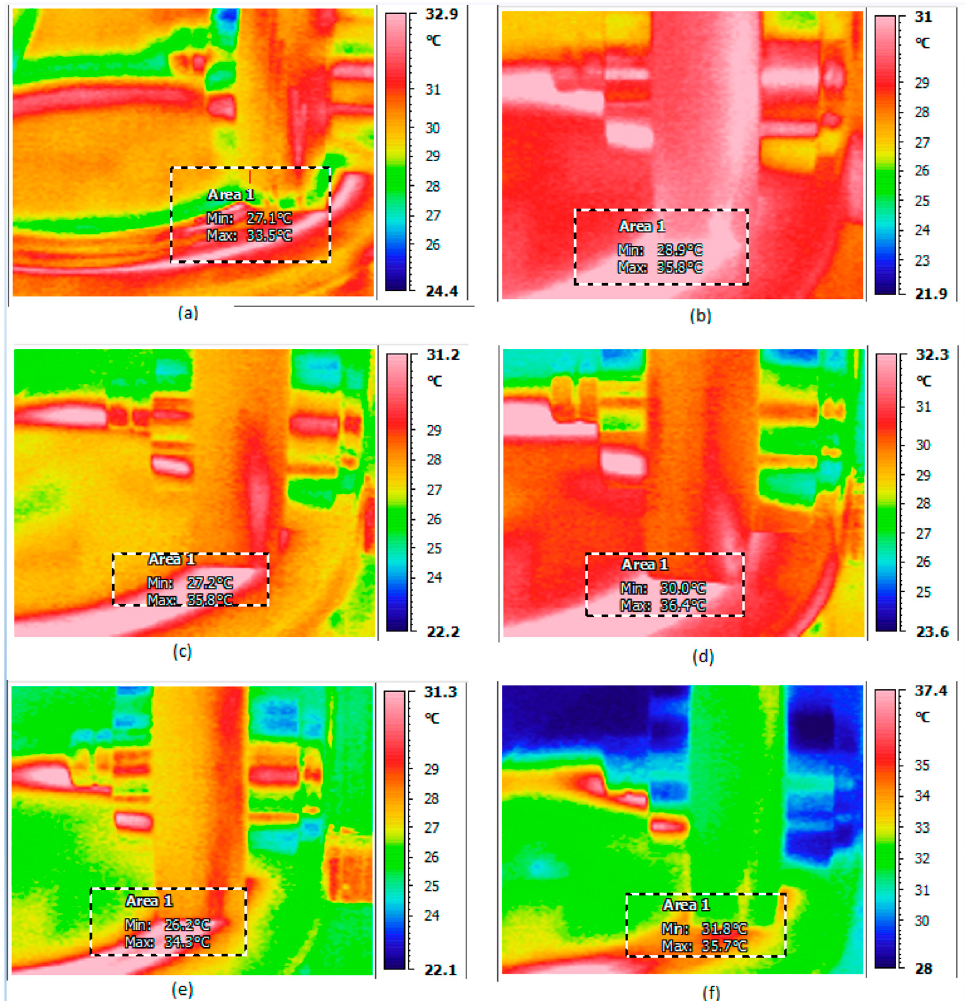
Figure 9. Thermal images captured for different composites: ( a ) 0.5 wt.% AMWCNT–epoxy–kenaf, ( b ) 0.5 wt.% SMWCNT-epoxy-kenaf, ( c ) 0.75 wt.% AMWCNT-epoxy-kenaf, ( d ) 0.75 wt.% SMWCNT- ( b ) 0.5 wt.% SMWCNT–epoxy–kenaf, ( c ) 0.75 wt.% AMWCNT–epoxy–kenaf, ( d ) 0.75 wt.% epoxy-kenaf, ( e ) 1 wt.% AMWCNT-epoxy-kenaf, and ( f ) 1 wt.% SMWCNT–epoxy–kenaf, ( e ) 1 wt.% AMWCNT–epoxy–kenaf, and ( f ) 1 wt.% SMWCNT–epoxy–